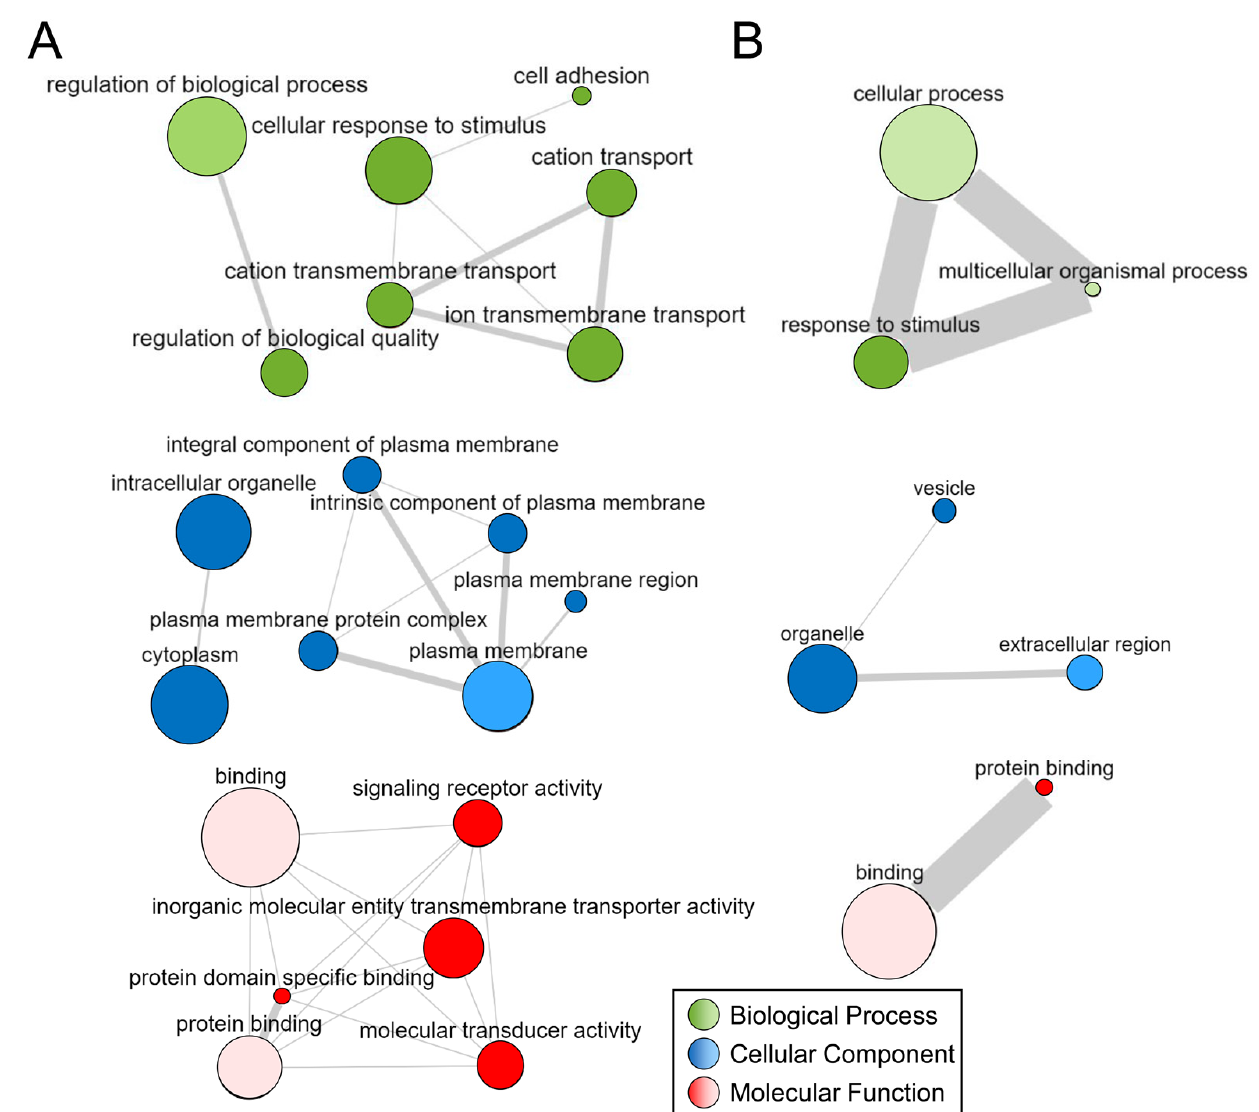
Figure 2. Networks derived from significantly enriched ontologies. The figure shows relationships of biological process (green), cellular component (blue), and molecular function (red) gene ontologies as visualized by the interactive graph module in REVIGO. Here, ontologies with greater significance ( q -value) are larger and similar terms are linked by bars whose width indicates the degree of similarity (ontologies without links are not visualized here). ( A ) Enriched ontologies in significant genes with higher expression in IA. ( B ) Enriched ontologies in significant genes with lower expression in IA. (Abbreviations: REVIGO = REduce and VIsualize Gene Ontology).